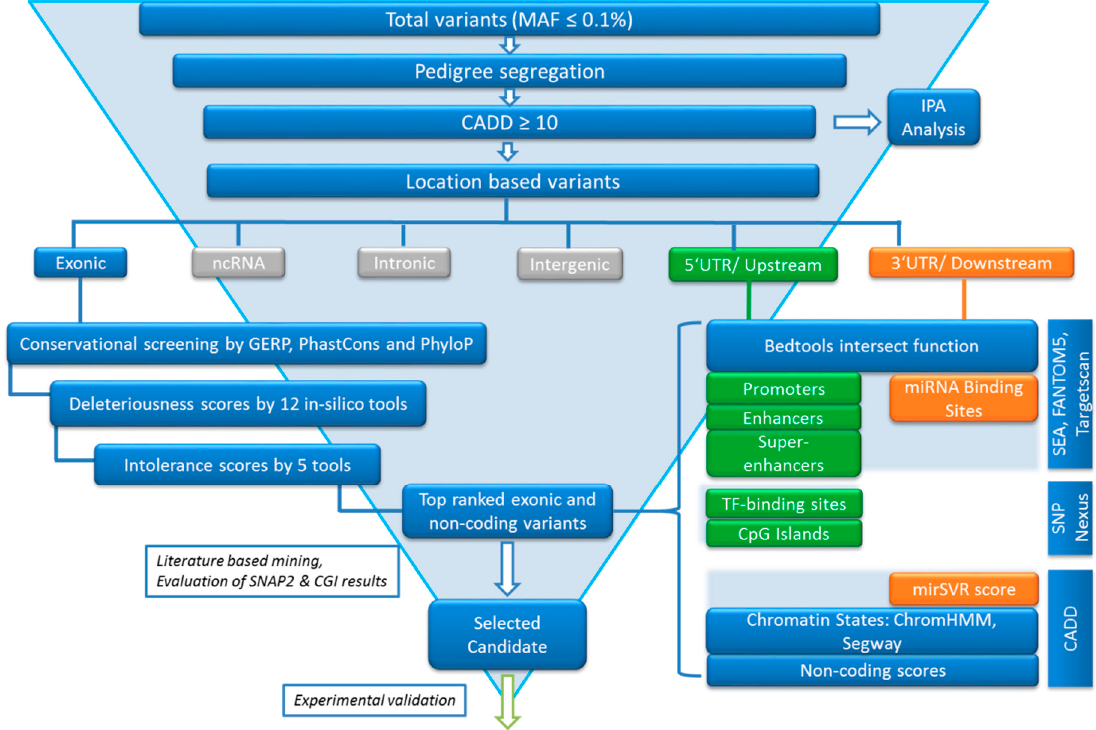
Figure 2. Summary of the familial cancer variant prioritization pipeline version 2 (FCVPPv2).